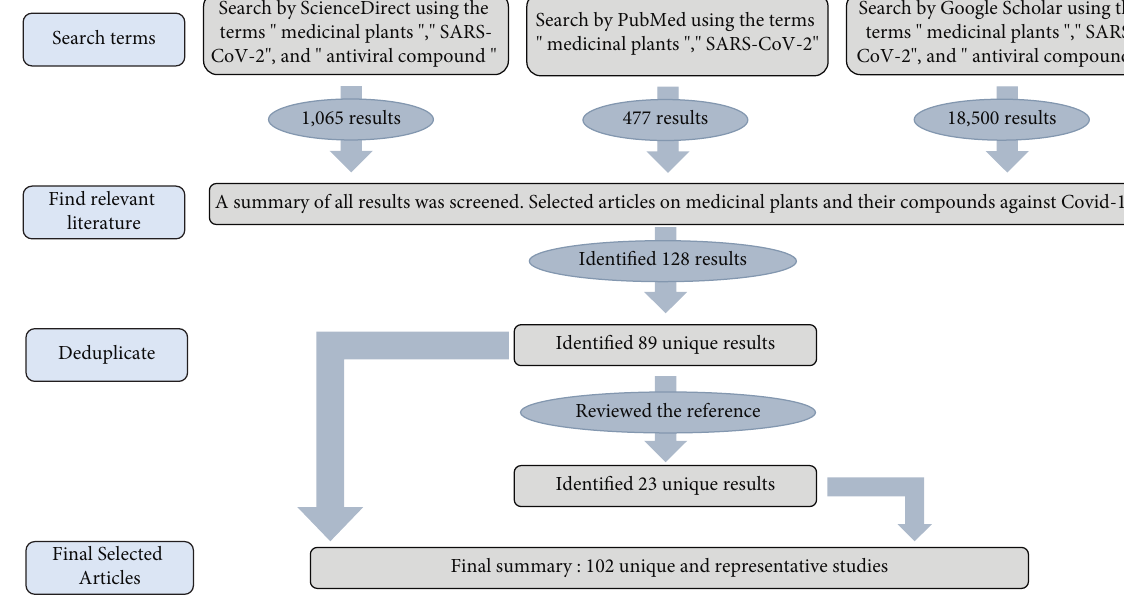
Figure 1: PRISMA diagram of the systematic literature